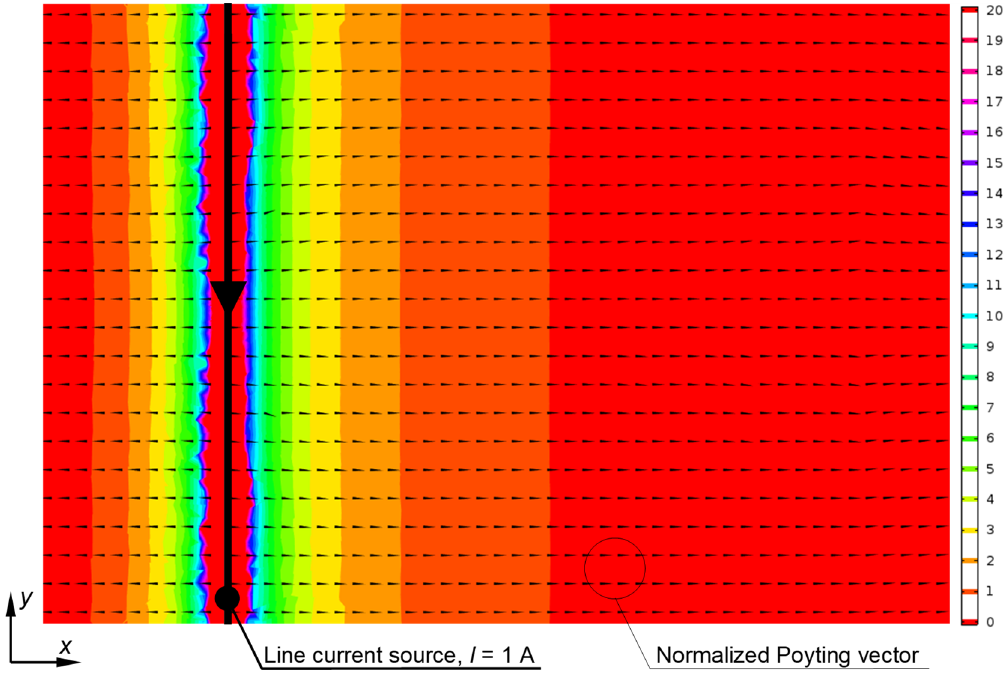
Figure 6. Magnetic field norm (color) and normalized power flow (black arrows) for the model without the magnetic meta-hose.